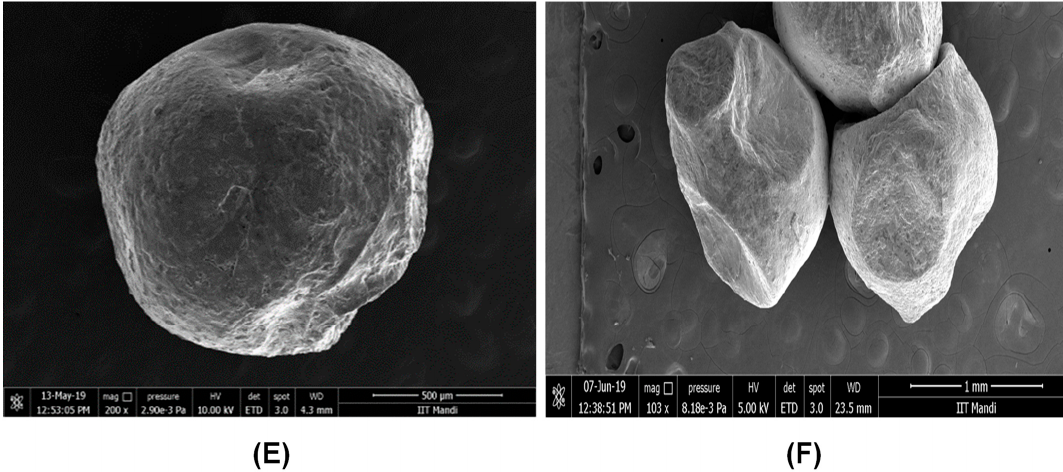
Figure 2. Field emission scanning electron microscopy images of ( A ) alginate+xanthan gum; ( B ) alginate+gum acacia; ( C ) alginate+carrageenan; ( D ) alginate+starch; ( E ) alginate+chitosan; and ( F ) alginate+sodium caseinate microcapsules.